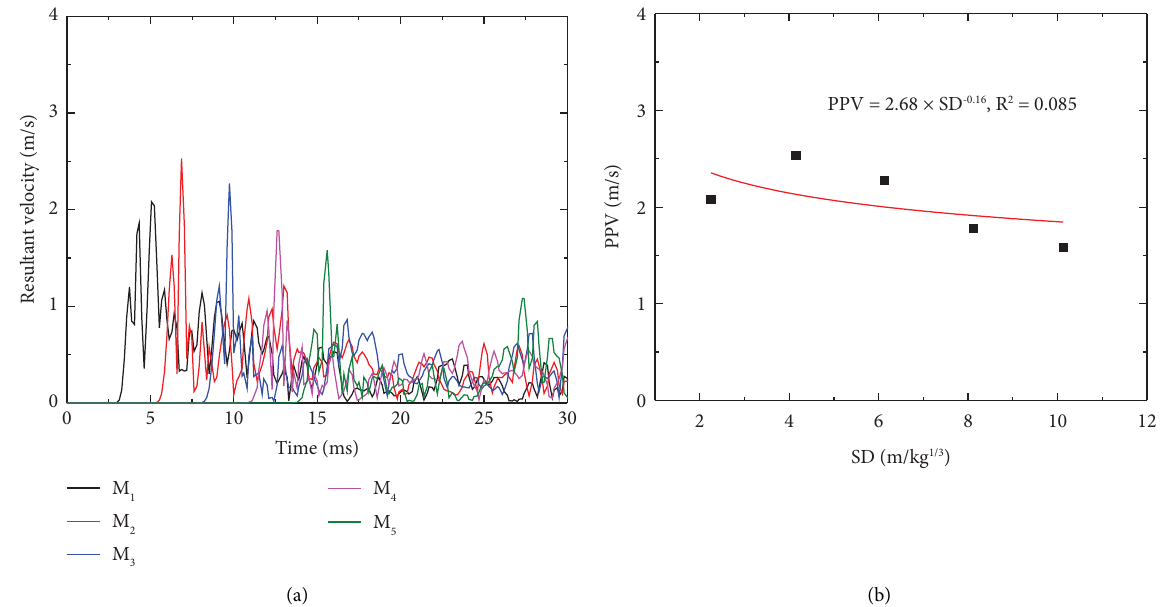
Figure 5: Resultant velocity time histories and PPV of ground vibration induced by blasting with a vibration-isolating slot. (a) Resultant velocity time histories. (b) PPV.